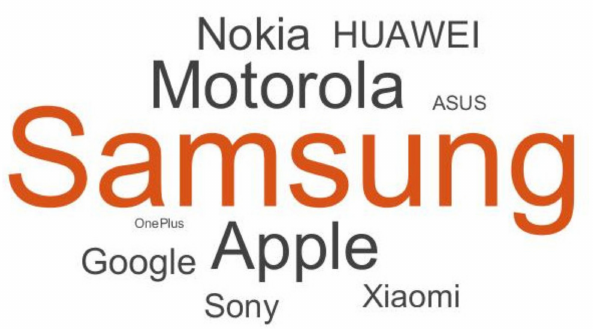
Figure 12. Word-cloud plot analysis for brand and its total number of items.